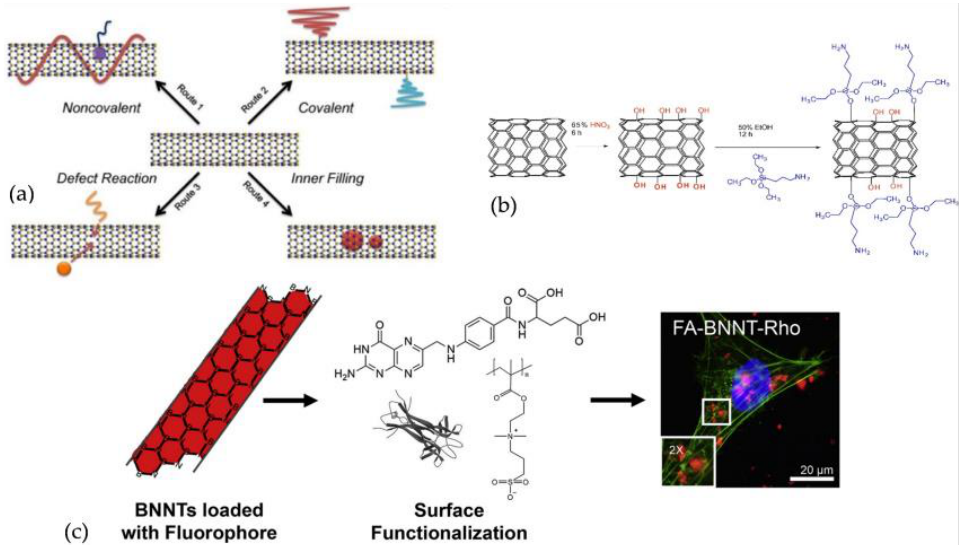
Figure 3. ( a ) Various BNNTs functionalisation methods. Reproduced with permission from Ref.